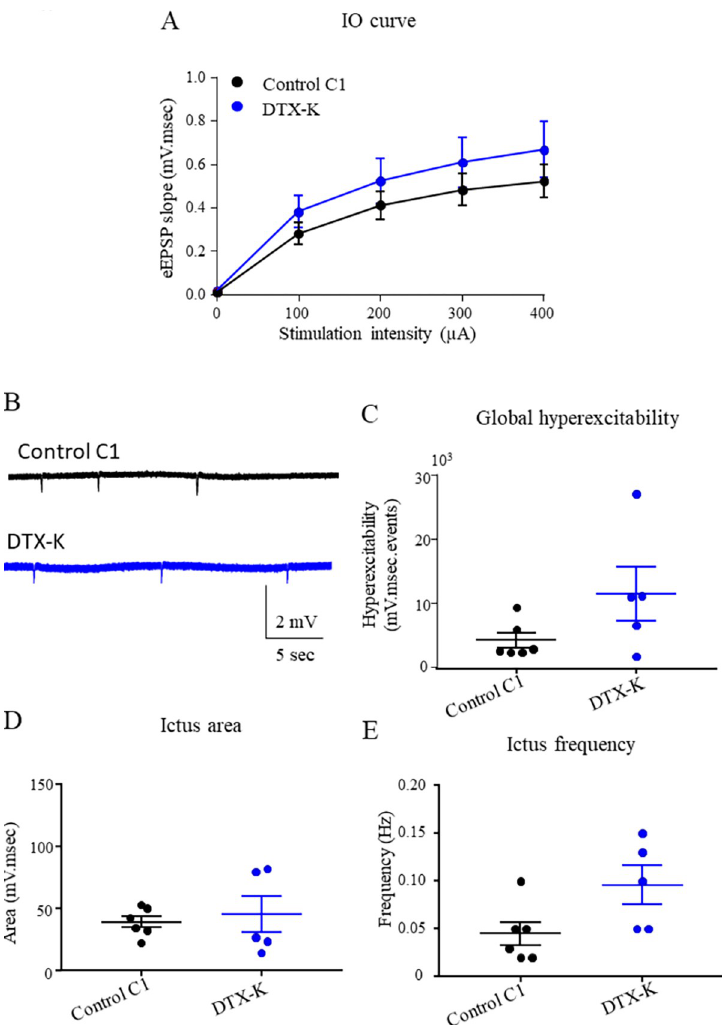
IgG infusion (Dunn’s post Hoc test DTX-K- Ctrl p = 0.11) (C) as well as the area of the ictus (Fisher LSD post Hoc test, Ctrl-DTX-K p = 0.73) (D) while frequency is not significantly increased (Kruskal-Wallis test, p = 0.09) (E). Data are represented as mean ± SEM (n Ctrl = 6 mice, n DTX-K = 5